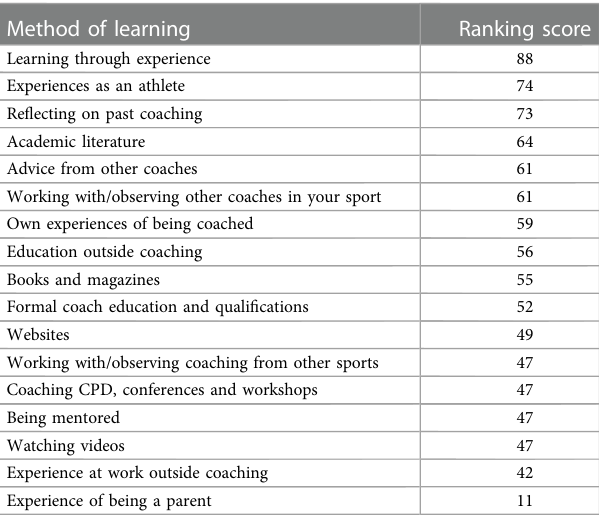
TABLE 8 Rating of importance of the following sources of information in developing coaches